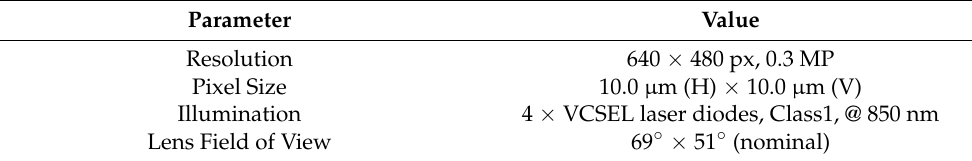
Table 3. Specifications of the TOF